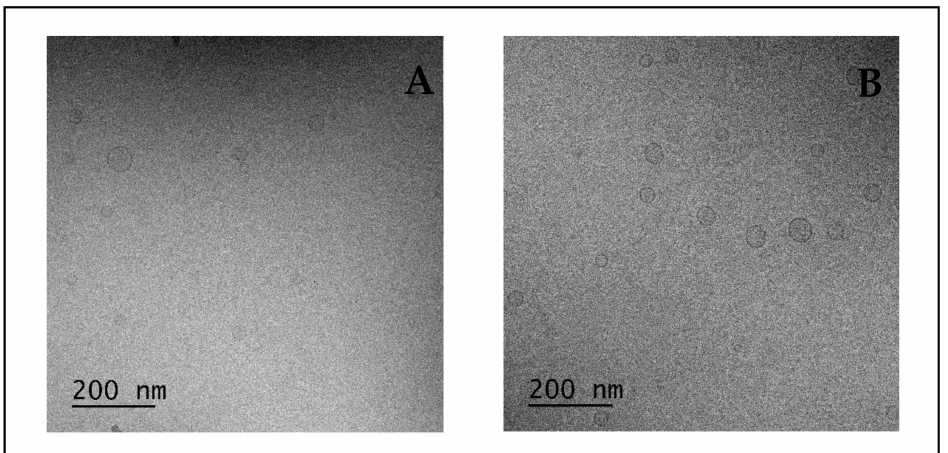
Figure 4. NE from SNEDDS 30 mg/mL diluted at 1:100 in MilliQ water ( A ) or PBS (pH 7.4) ( B ) from cryo-TEM images (50,000 × ).